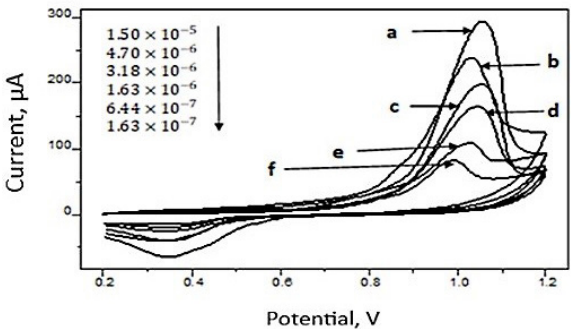
Figure 9. The calibration voltammograms at different concentra- tions of ziram in BR buffer (pH 8) at AuNPs/RGO/GCE by DPV (a)1.50 ×10 –5 ; (b) 4.70 × 10 –6 ; (c) 3.18 × 10 –6 ; (d) 1.63 × 10 –6 ; (e) 6.44 × 10 –7 ; (f)1.63 × 10 –7 mol L –1